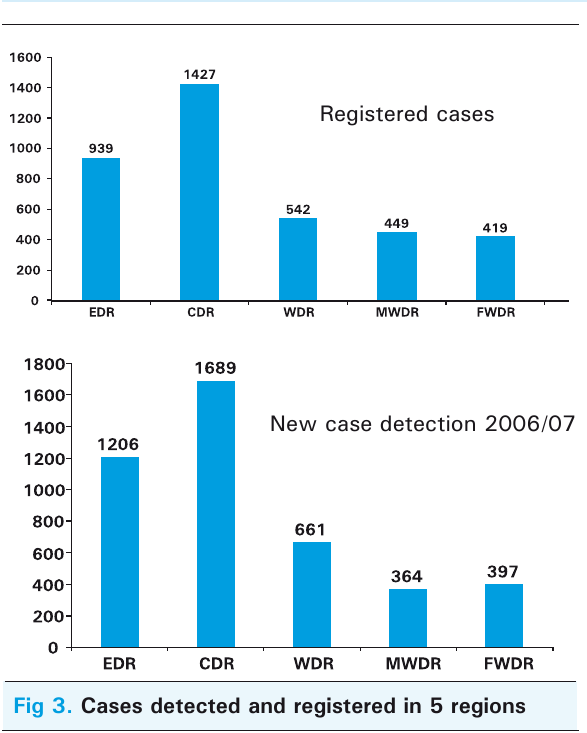
Fig 3. Cases detected and registered in 5 regions EDR=Eastern Development region, CDR=Central Development Region, WDR=Western Development Region, MWDR=Mid-west Development Region, FWDR=Far-western Development Region, NCDR=New Case Detection Rate